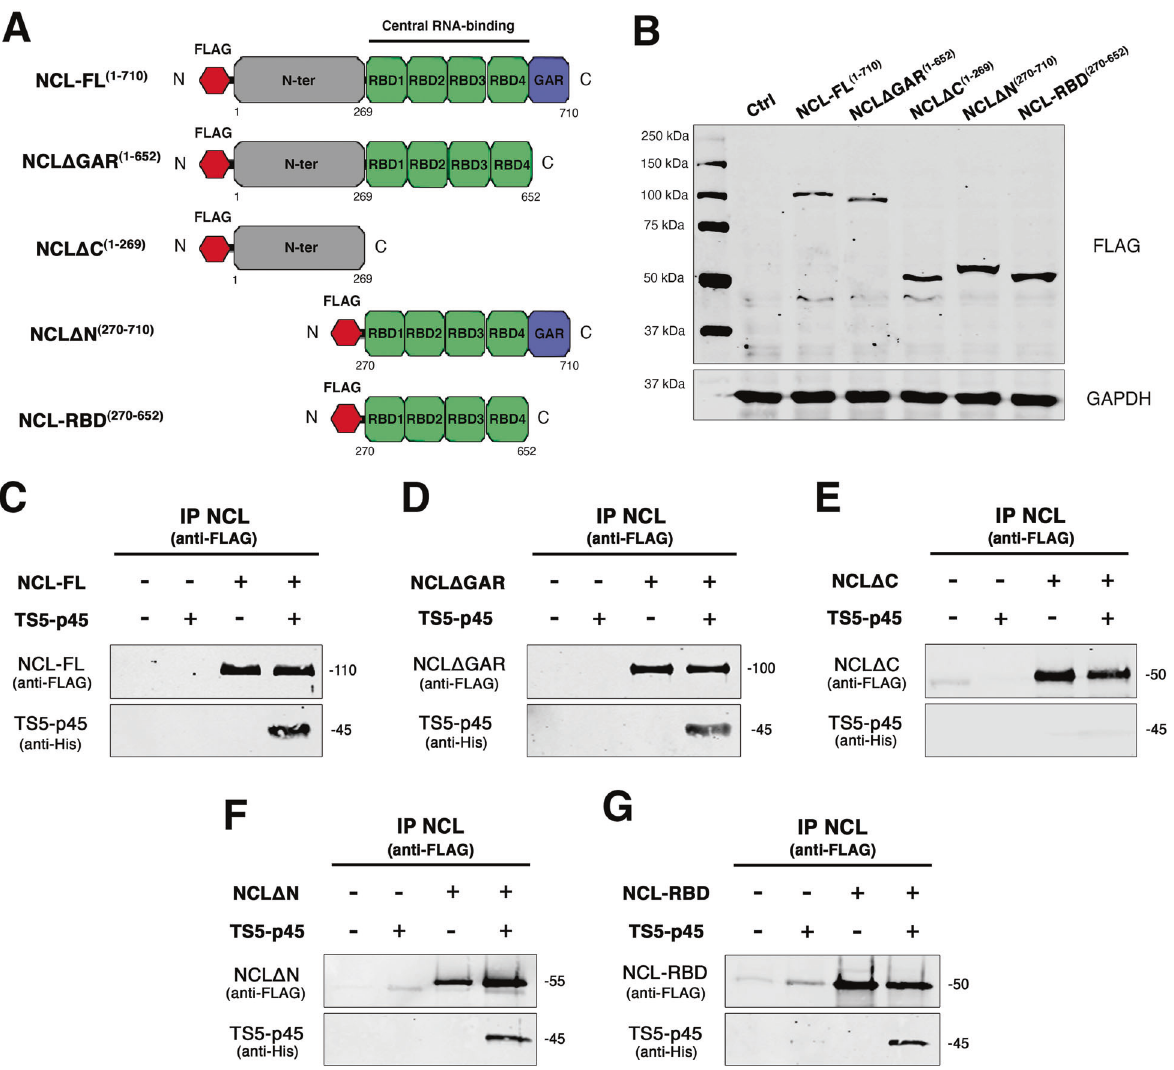
Fig. 3 NCL binds to TS5-p45 through its RNA binding domains (RBDs). A Schematic representation of NCL expression constructs with N-terminal FLAG tag encoding NCL-FL 1-710 , NCL Δ GAR 1-652 , NCL Δ C 1-269 , NCL Δ N 270-710 , and NCL-RBD 270-652 . B Expression of NCL and truncates in HEK293T cells by WB via anti-FLAG antibody. GAPDH was used as a loading control. C – G Co-IP analyses of FLAG-tagged NCL and truncates against His-tagged TS5-p45. Binding between TS5-p45 and C NCL-FL 1-710 , D NCL Δ GAR 1-652 , E NCL Δ C 1-269 , F NCL Δ N 270-710 , G NCL-RBD 270-652 were shown by anti-FLAG and anti-His blotting,